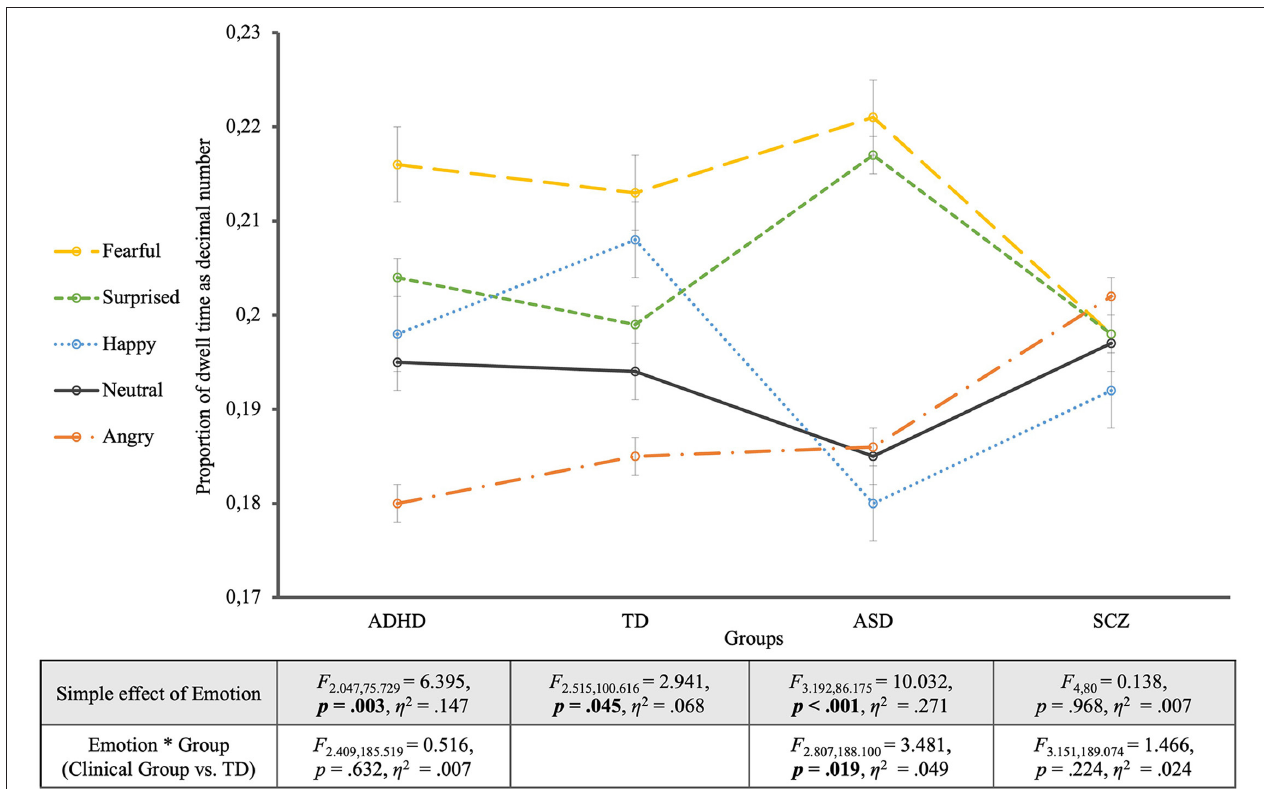
FIGURE 2 | Proportion of dwell time for the four groups. The groups are located on the horizontal axis with the different emotions as single lines. The table shows the statistics of the simple effects of EMOTION as well as the interaction effects EMOTION * GROUP.